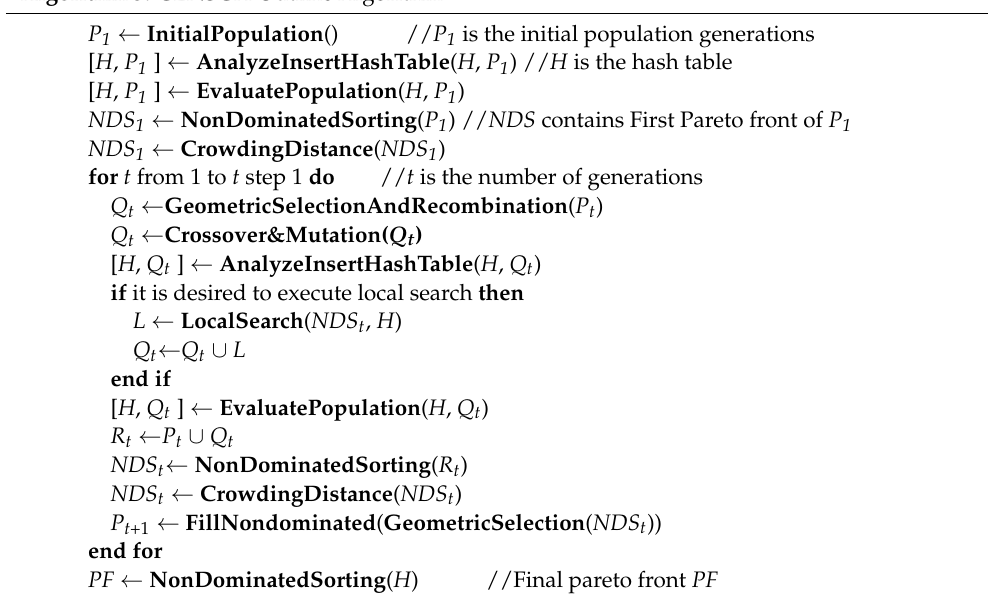
Algorithm 3. CENSGA Outline